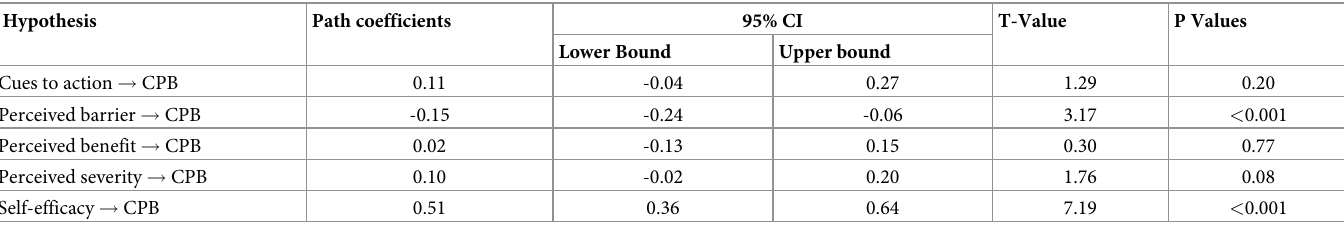
Table 7. Path coefficient of the structural equation modeling analysis of CPB among secondary school students in Gondar city, Northwest Ethiopia, 2020 (n =